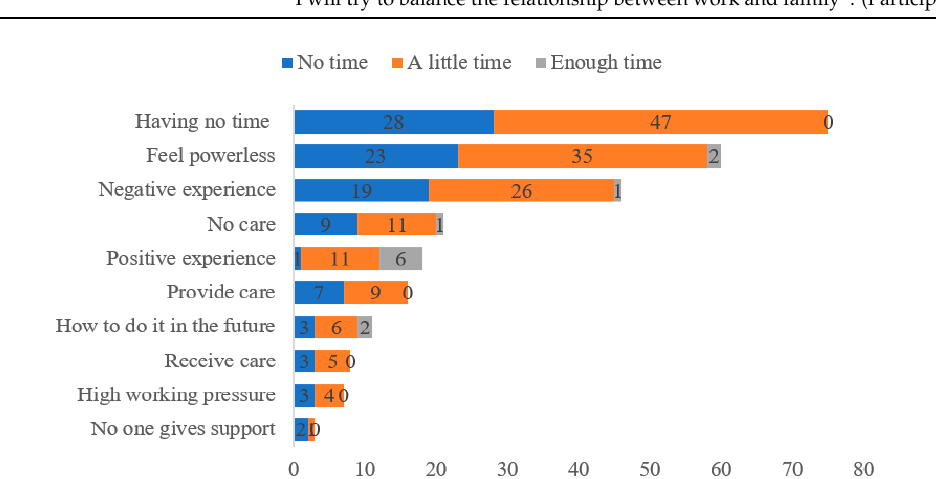
Figure 4. Coding counts between different family companion groups.